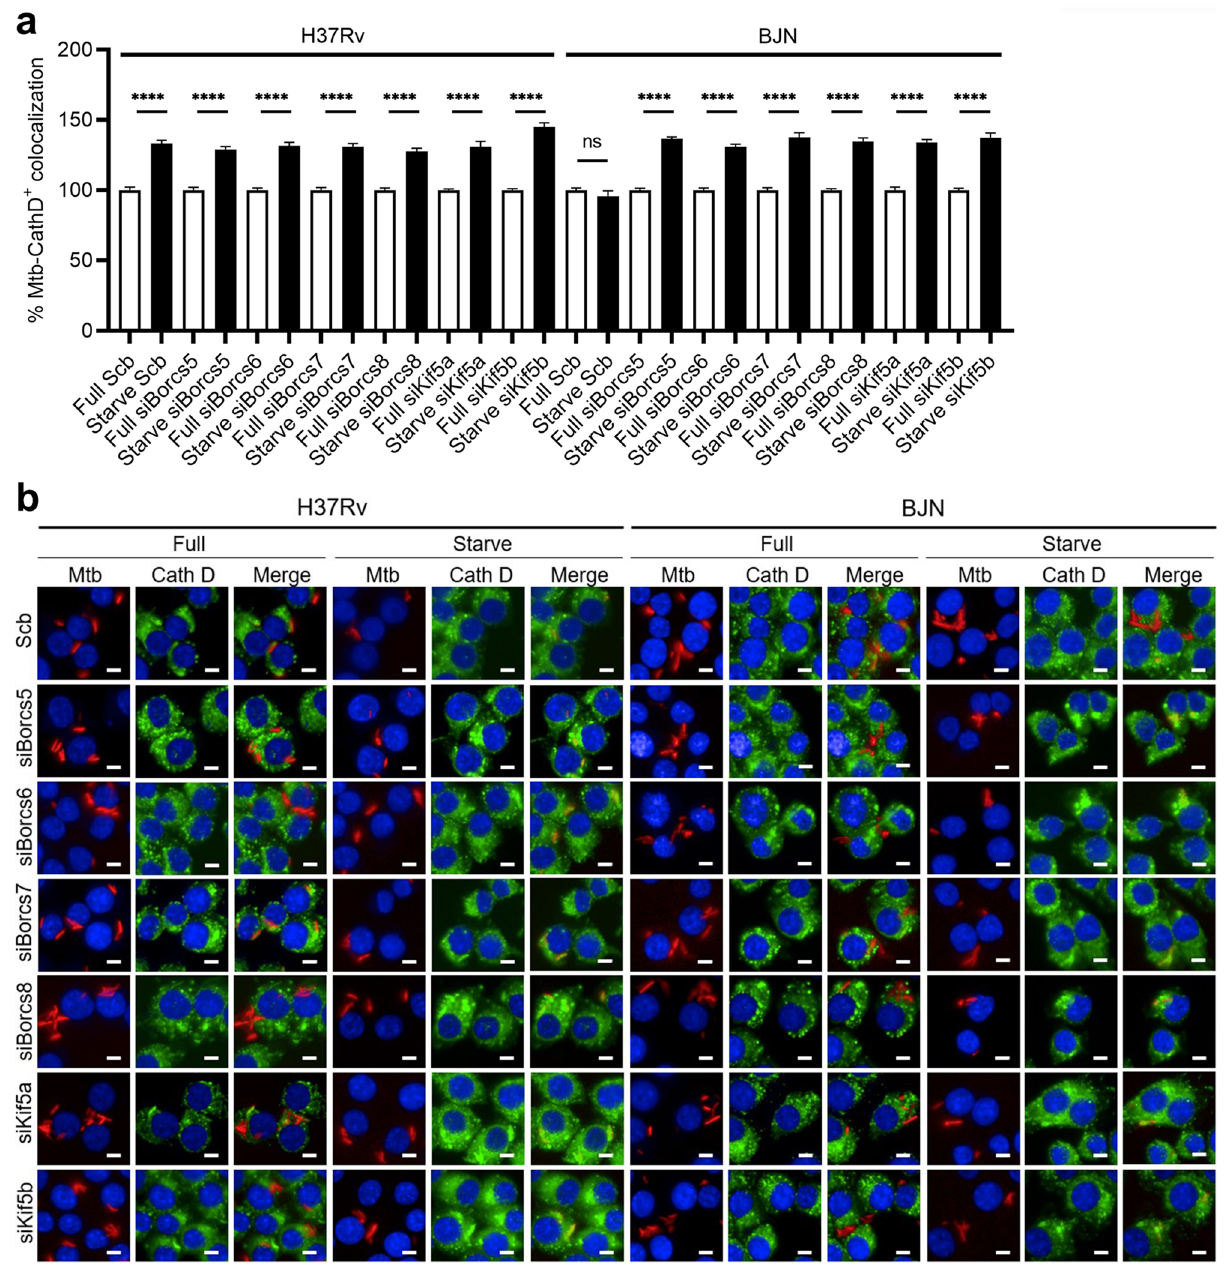
Figure 2. BORCS5-8 and Kinesin-1 impair lysosomal delivery to the BJN phagosomes in RAW264.7 macrophages. ( a,b ) RAW264.7 macrophages depleted in BORCS5-8 and Kinesin-1 expression were infected with the mCherry-expressing H37Rv or BJN for 15 min and chased for 1 h. Autophagy was then induced by starvation for 2 h. Cells were fixed and stained for lysosomes using an anti-Cathepsin D antibody followed by nuclear labelling with Hoechst. Percent mycobacteria-Cathepsin D colocalisation was then analysed by high- content image analysis. Data are means ± SEM from at least three independent experiments; ns non-significant and ****p < 0.0001, all relative to the full control set of 100% determined by one-way ANOVA with Tukey’s multiple comparison test ( a ). Representative images are displayed in ( b ). Bar 5 BORCS5‑8 and Kinesin‑1 mediate enhanced lysosome positioning towards the cell periphery by the BJN.